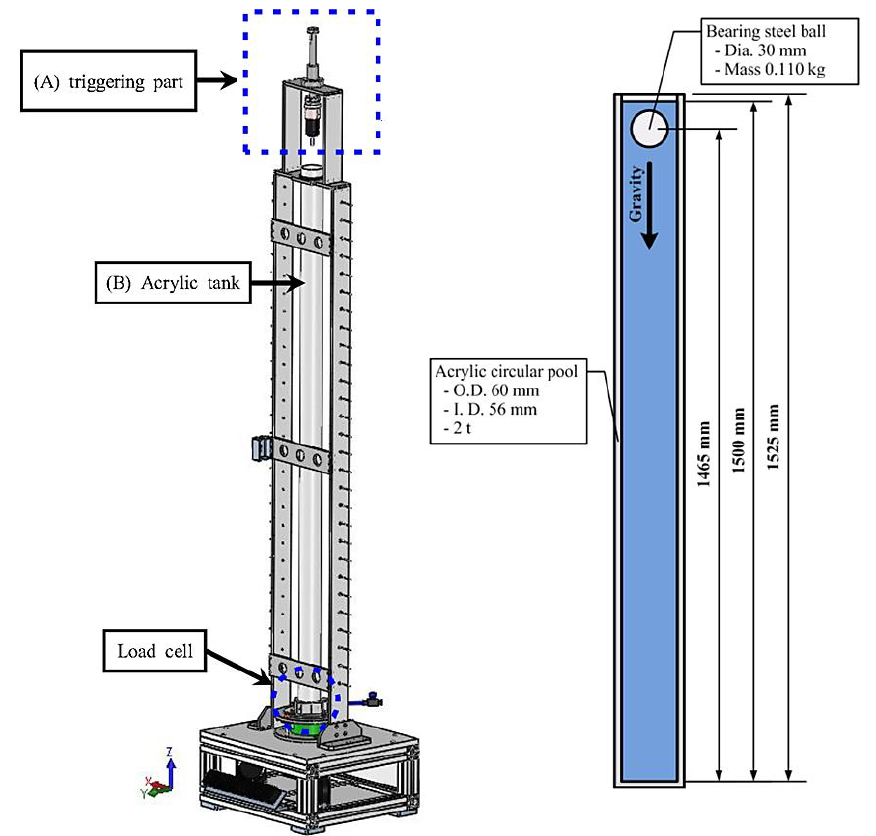
Figure 4. Underwater drop test scheme of bearing steel sphere [26].